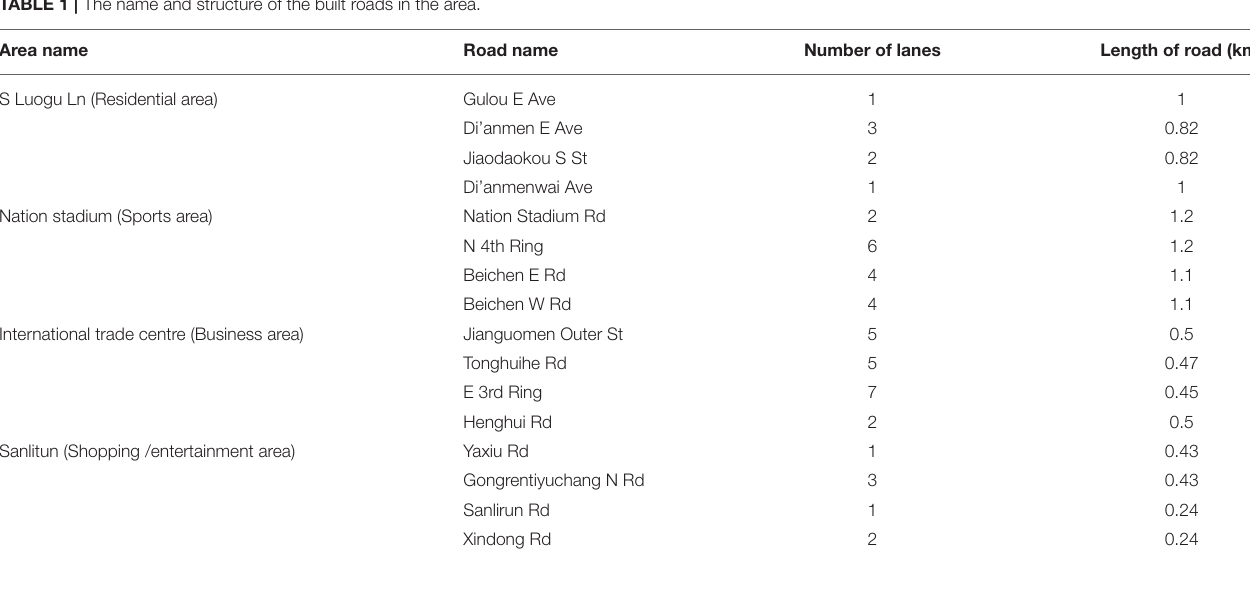
TABLE 1 | The name and structure of the built roads in the